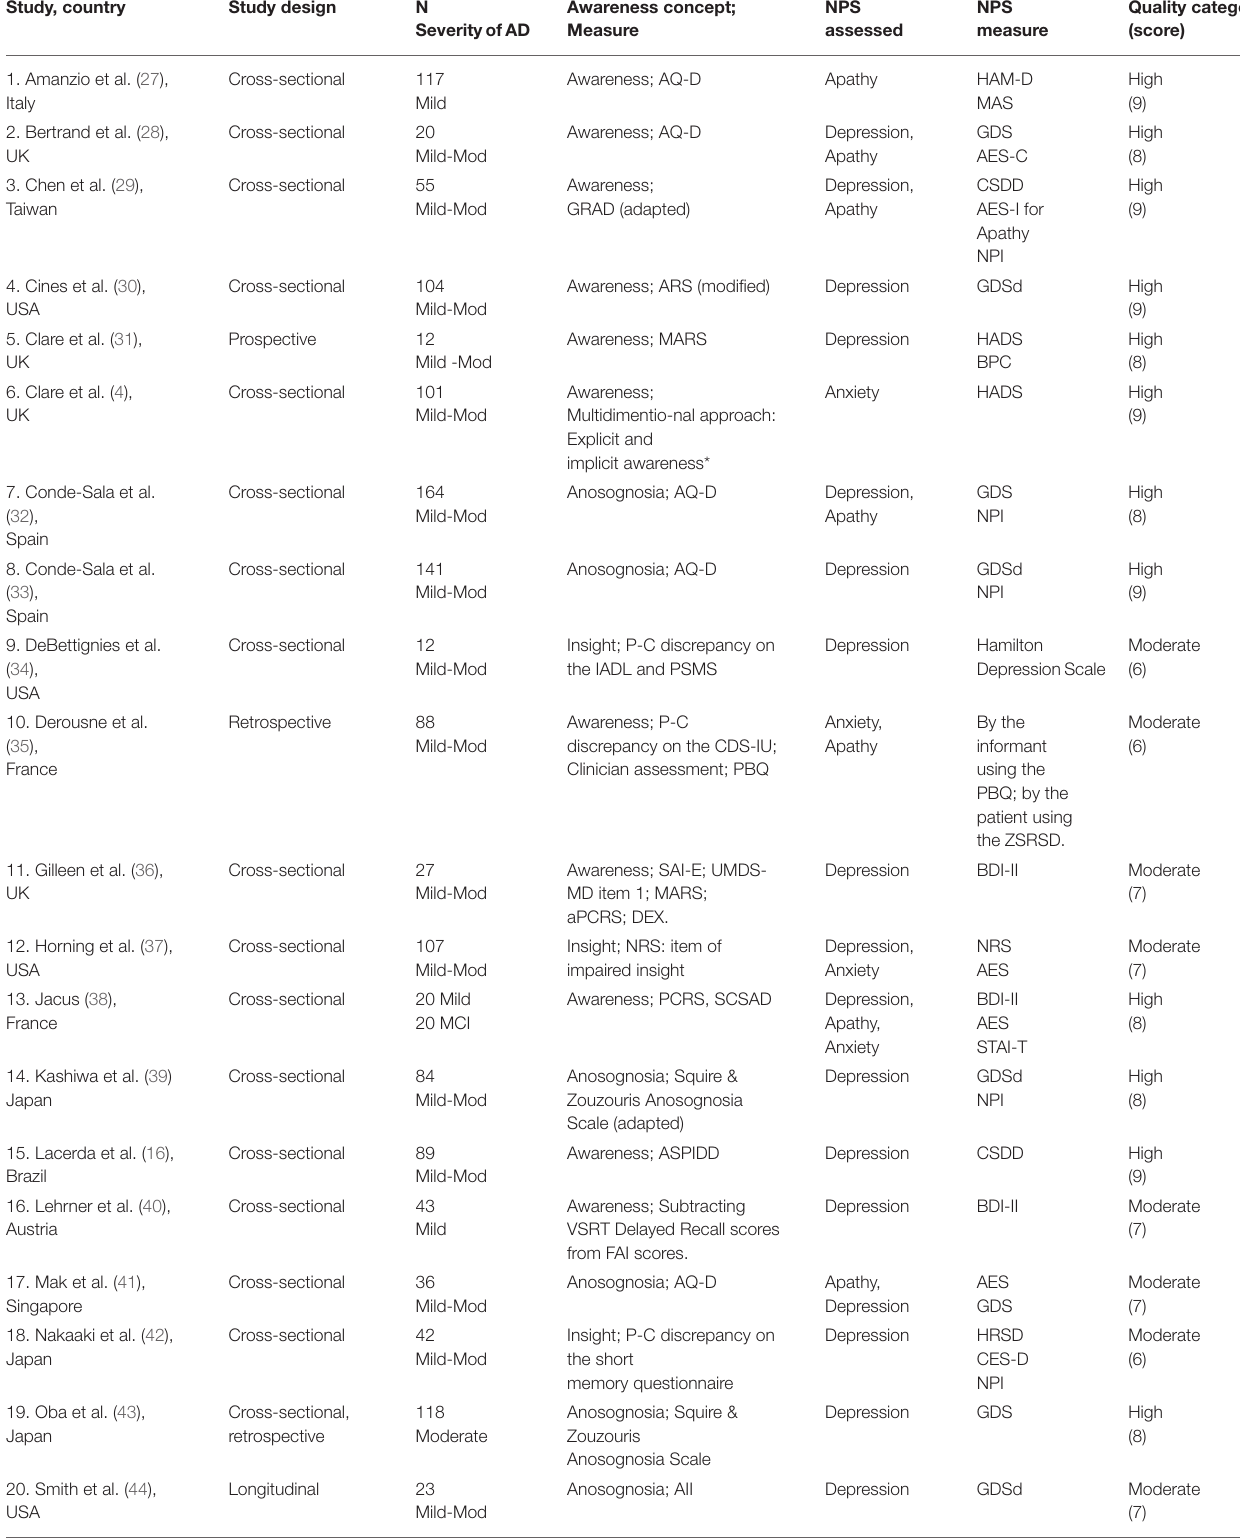
TABLE 1 | Characteristics of included